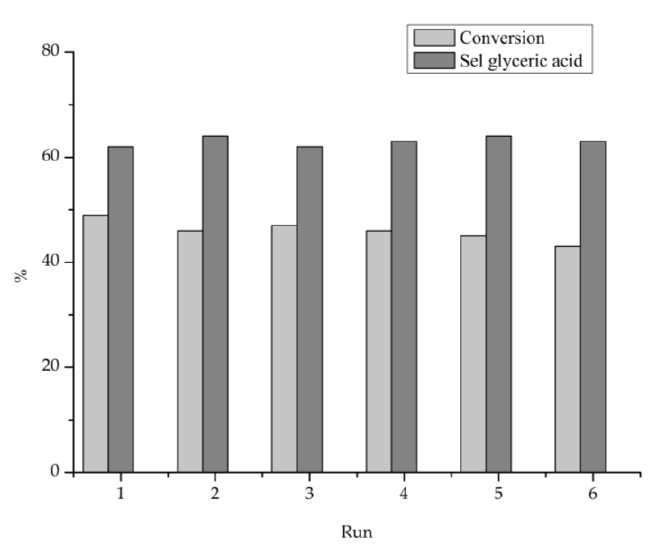
Figure 6. Stability test for Au 6 Pt 4 /AC in the base free glycerol oxidation, reaction time: 5 h.